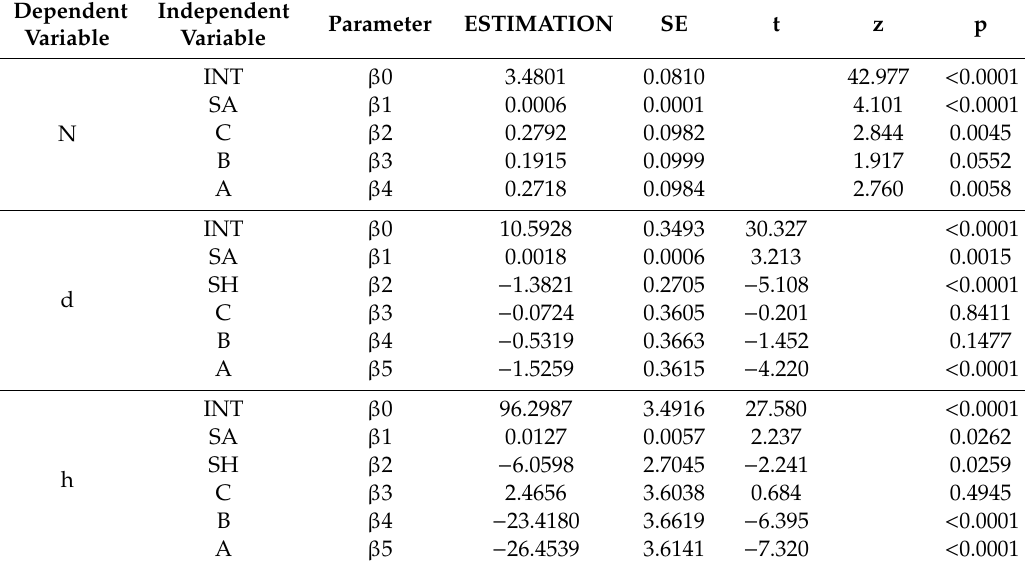
Table 3. Estimated values of the parameters for the selected